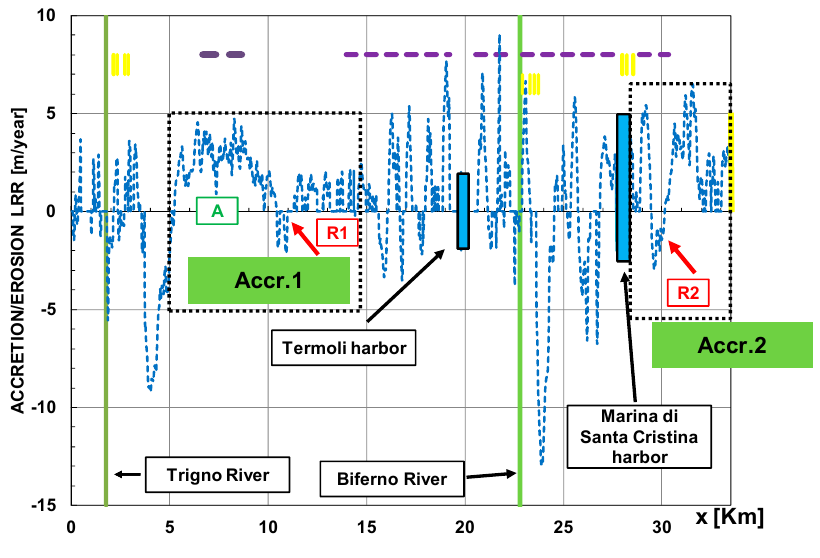
Figure 19. LRR function during the period 2004–2011. Water 2020 , 12 , 2831